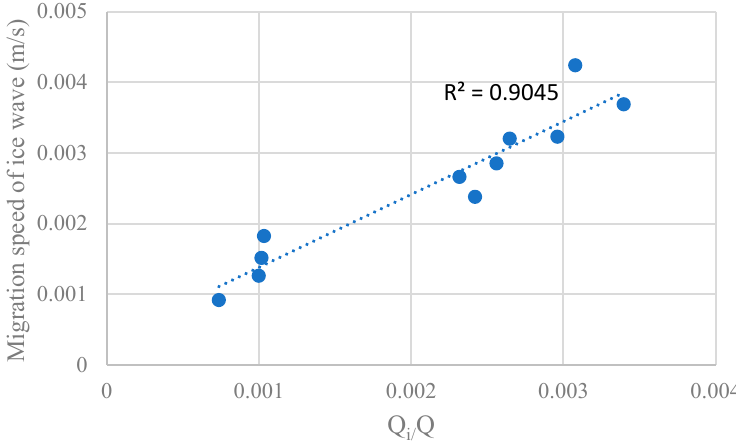
Figure 9. The relationship between the migration speed of ice wave and the ice-water discharge ratio ( Q i / Q ) from laboratory experiments.